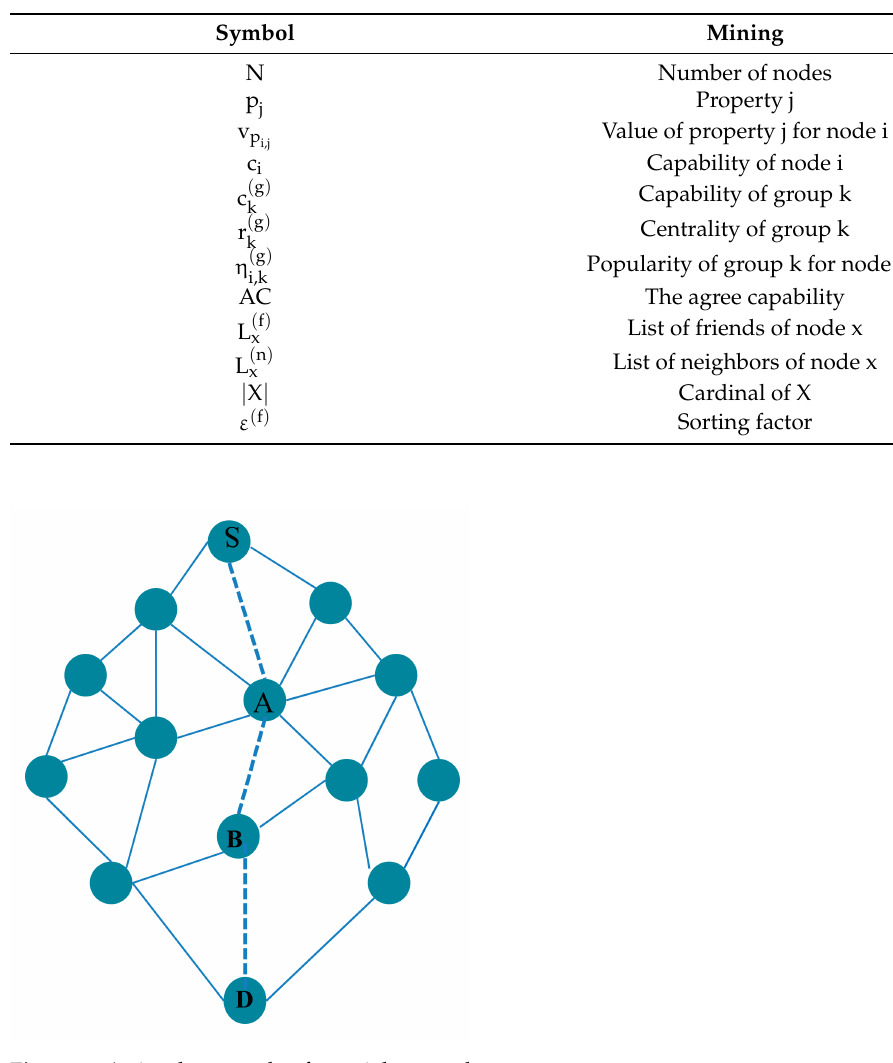
Figure 2. A simple example of a social